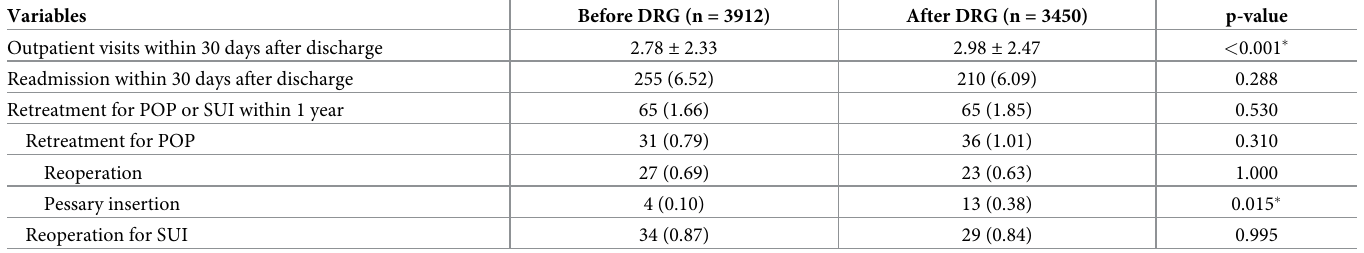
Table 4. Changes in outpatient visits, readmission, and retreatment for pelvic organ prolapse or stress urinary incontinence after the introduction of diagnosis- related group payment system.